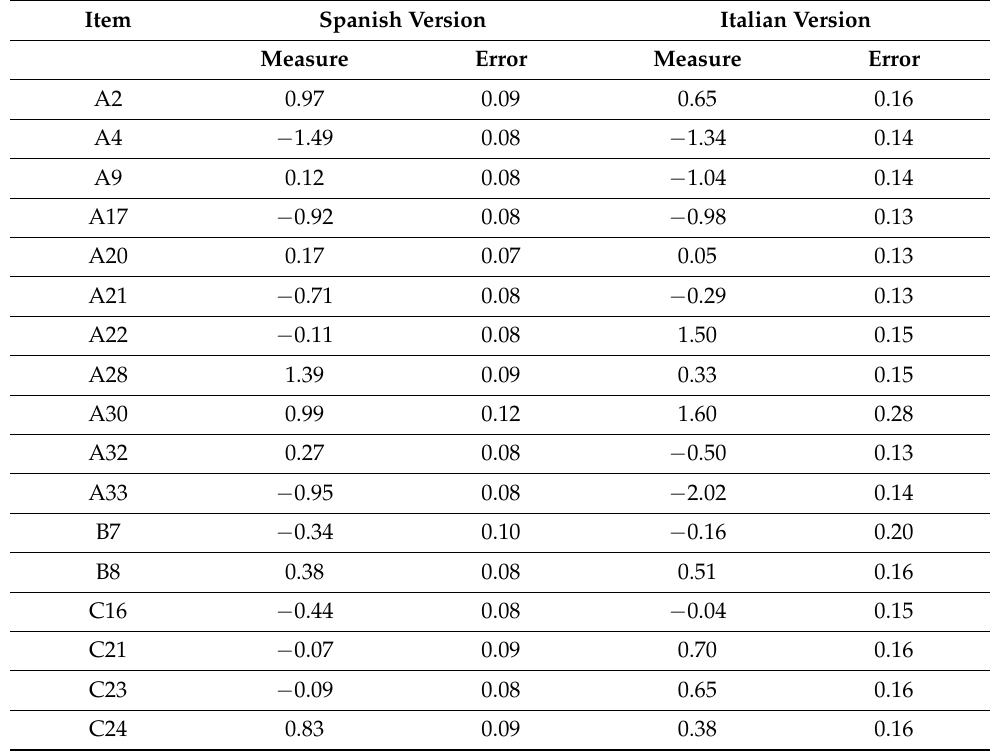
Table 5. Comparison of Italian and Spanish version of the CVSS for all item measures.